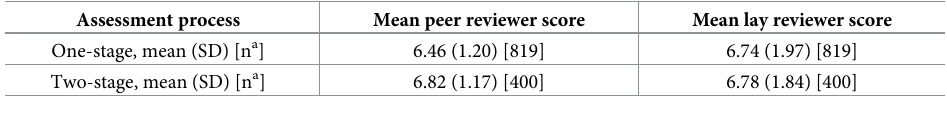
Table 1. Mean and standard deviation of mean peer and lay review